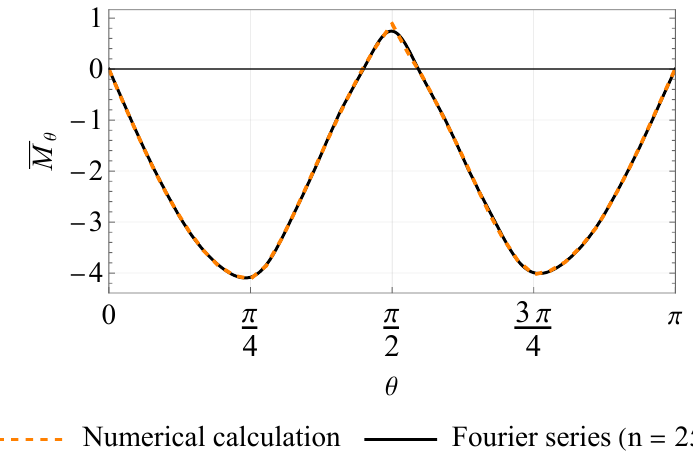
Figure 3. Restoring aerodynamic torque